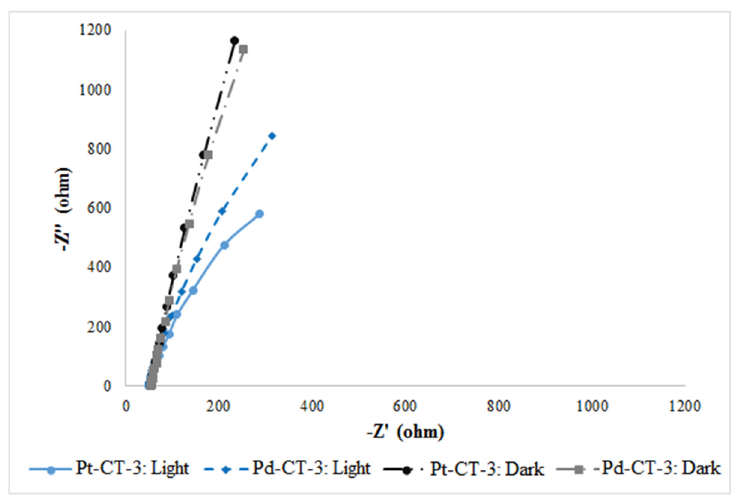
Figure 6. EIS plot of Pt-CT-3 and Pd-CT-3 under illumination and dark, in solution of KOH (1 M) with 5 vol% EG.